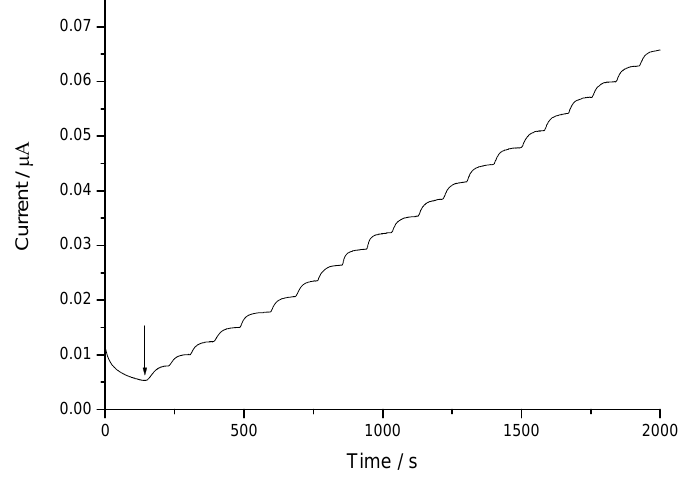
Figure 5. Dynamic response of the H H O steps in the solution at the applied potential of –0.25 V. 2 2